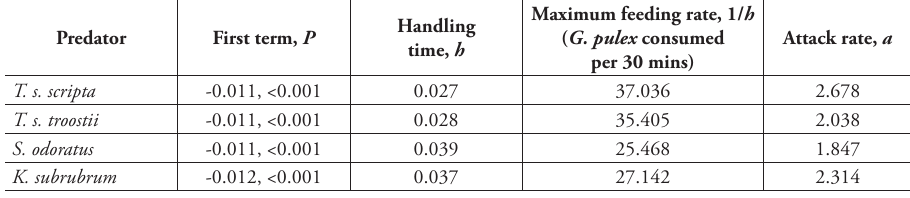
Table 2. First order terms calculated from logistic regression to denote functional response type across all predator treatments. The significant negative first order term values across all four turtles indicate Type II functional responses for each predator. Handling time ( h ), maximum feeding rate (1/ h ) and attack rate ( a ) parameter mean estimates (bootstrapped, n = 30), derived using Rogers’ random predator equation (eqn